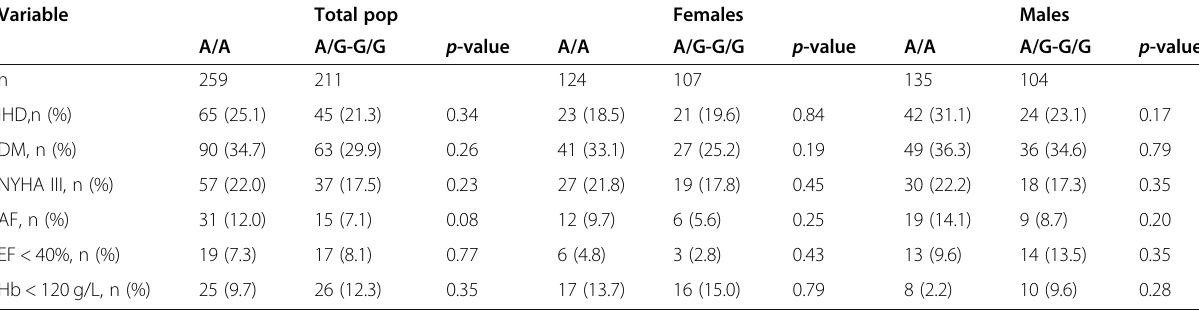
Table 8 Distribution of different well-known risk factors for cardiovascular mortality between the genotypes A/A and A/G or G/A amalgamated, of rs2228262 in the study population Variable